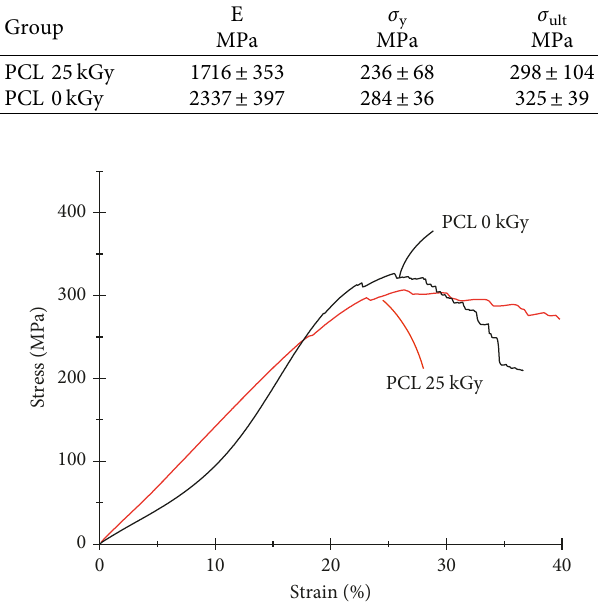
Figure 8: Stress-Strain behavior of sterilized groups.